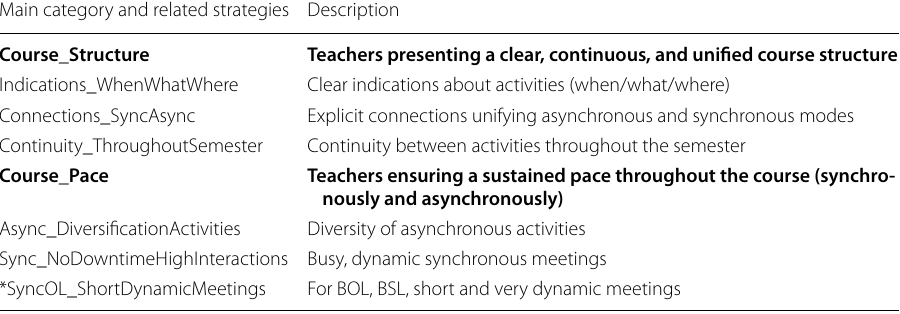
Boldface: meta-categories and categories of teachers’ strategies Regular text: teachers’ strategies inside a